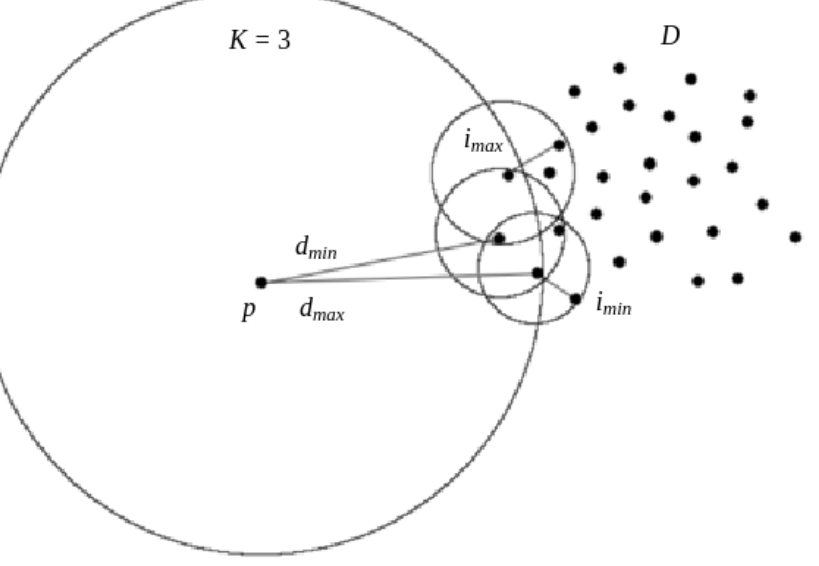
Figure 10. Density around normal data and